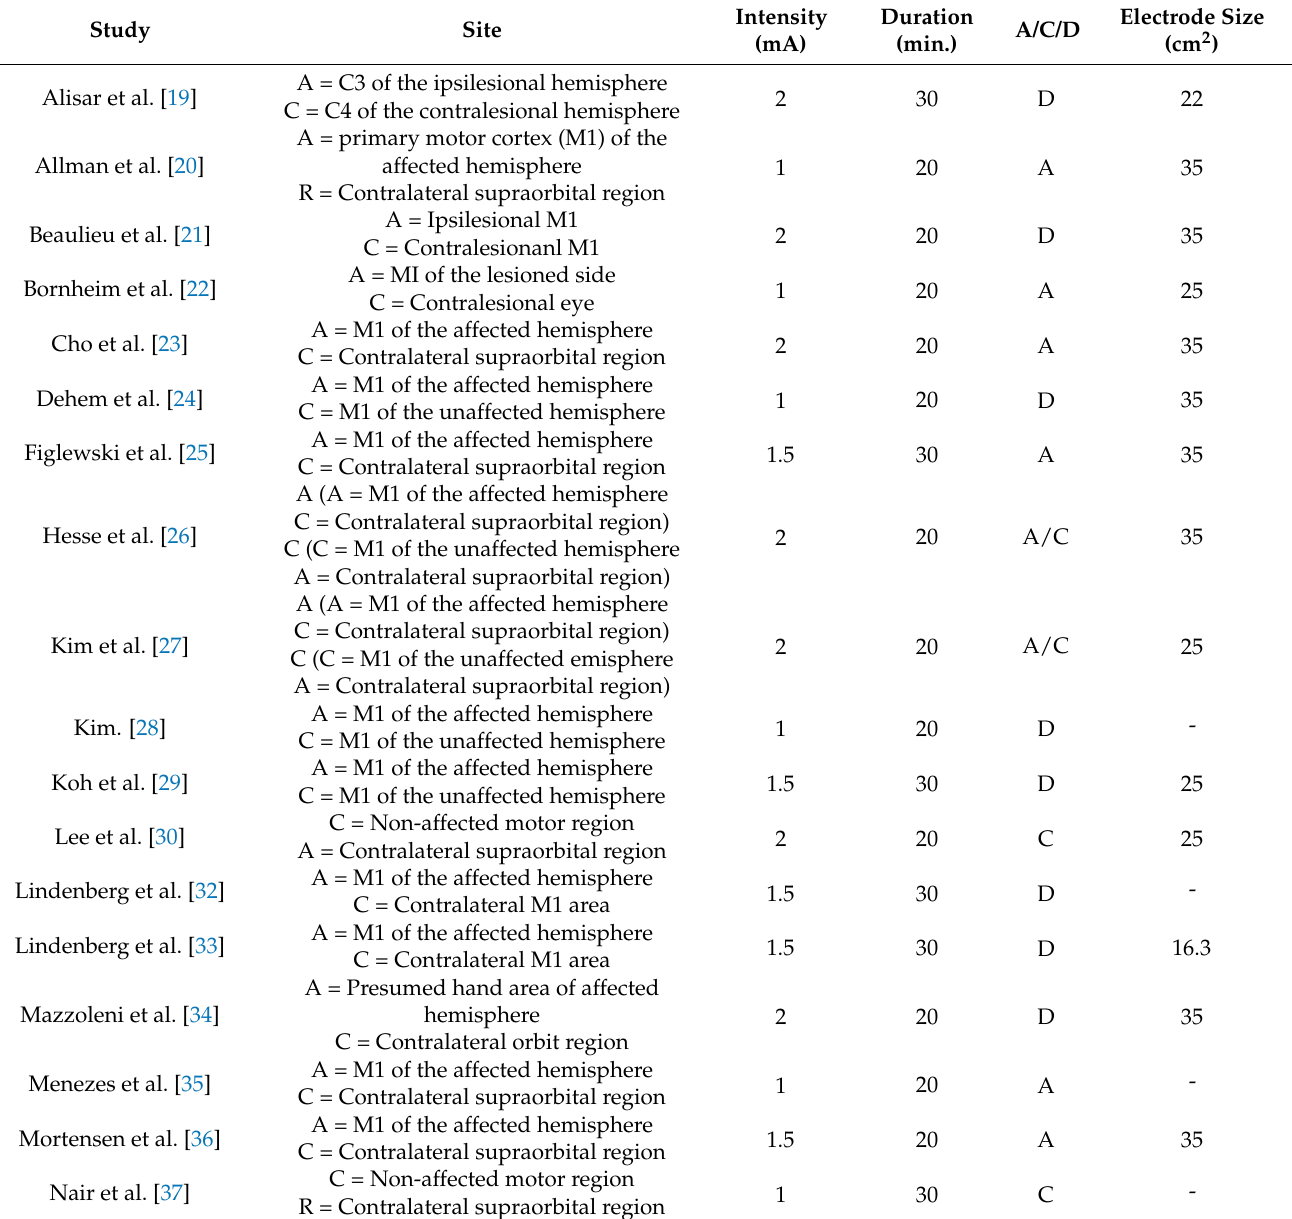
Table 2. Applied transcranial direct current stimulation (t-DCS) parameters for upper extremity function recovery in patients with